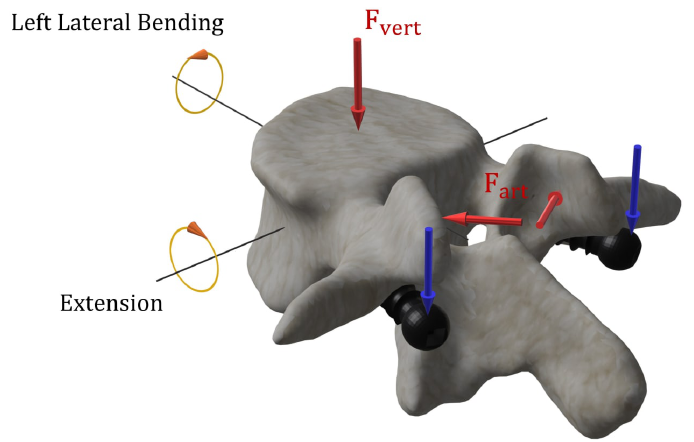
Figure 4. Boundary conditions applied on the vertebra and screws to mimic extension and left lateral bending loading cases. F vert and F art represent the compressive forces applied on the superior end plate and articular facets of the vertebra, respectively. The blue arrows indicate the loading direction applied on the screws. For the two loading cases, a uniform momentum was also applied along two different